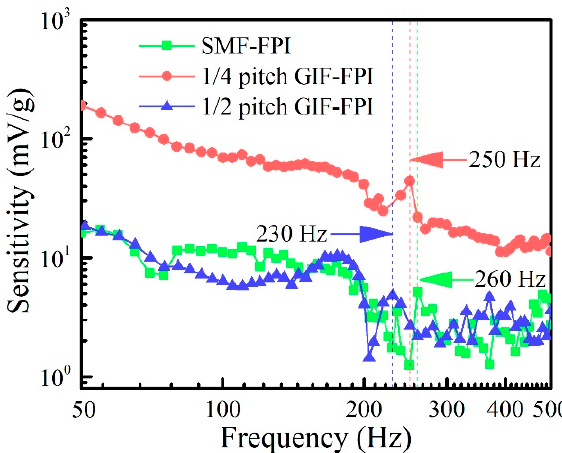
Figure 8. The frequency responses of the vibration sensors based on the SMF-FPI, the quarter-pitch GIF-FPI, and the half-pitch GIF-FPI with same cavity length of 200 µ m. Different vibration frequency ranging from 40 Hz to 500 Hz was investigated.